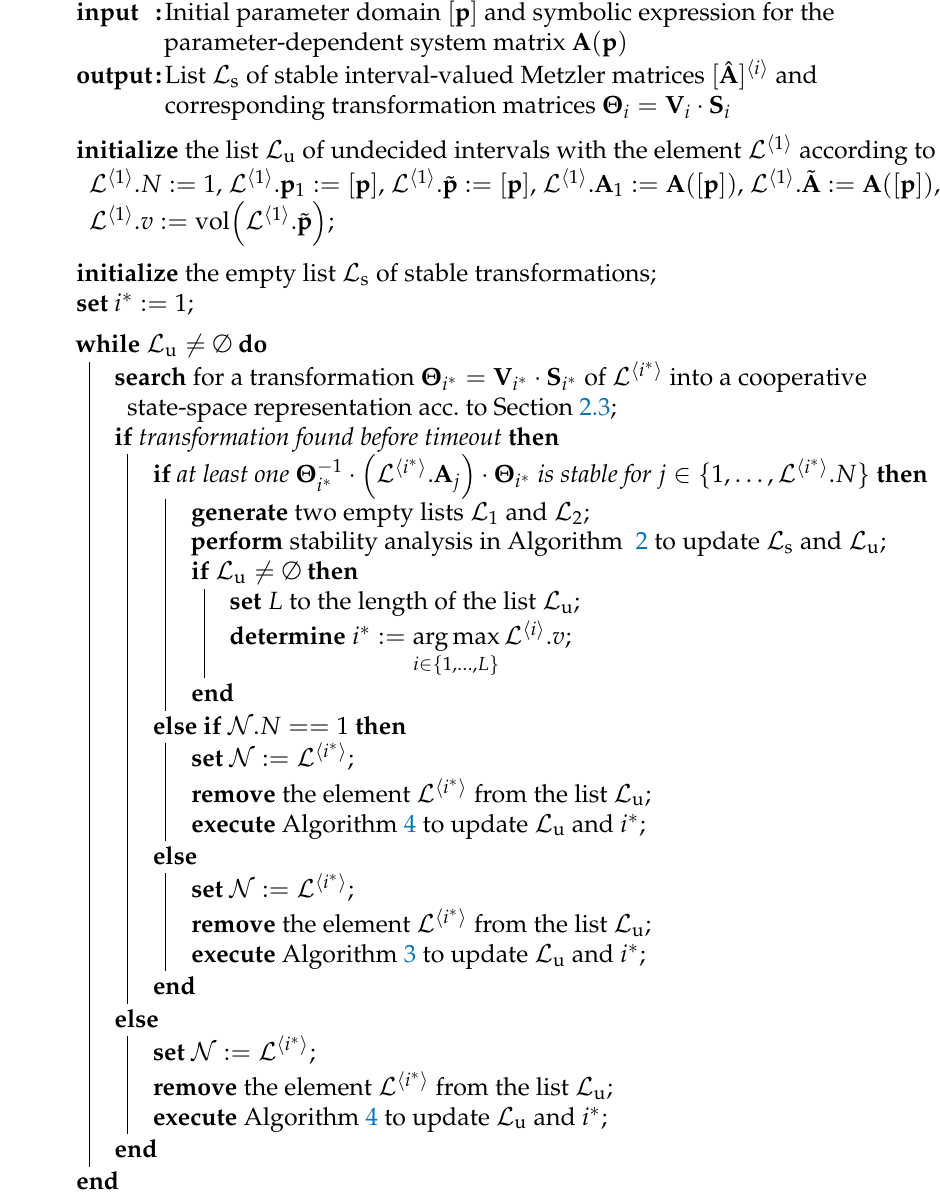
Algorithm 1: Splitting-based